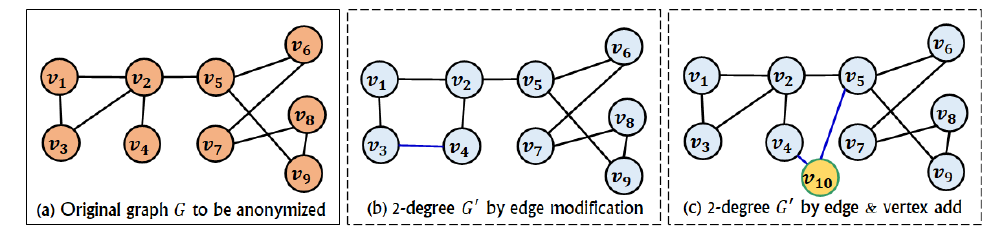
Figure 13. Example of G anonymization by the constrained anonymization method.